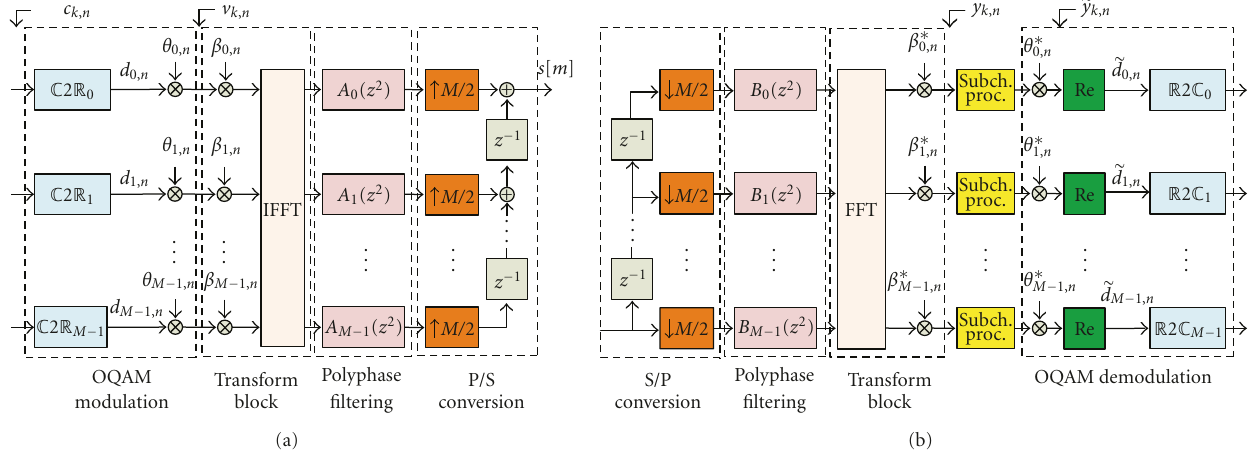
Figure 1: (a) Synthesis and (b) analysis filter banks for complex FBMC transmultiplexer (TMUX) with per-subchannel processing.